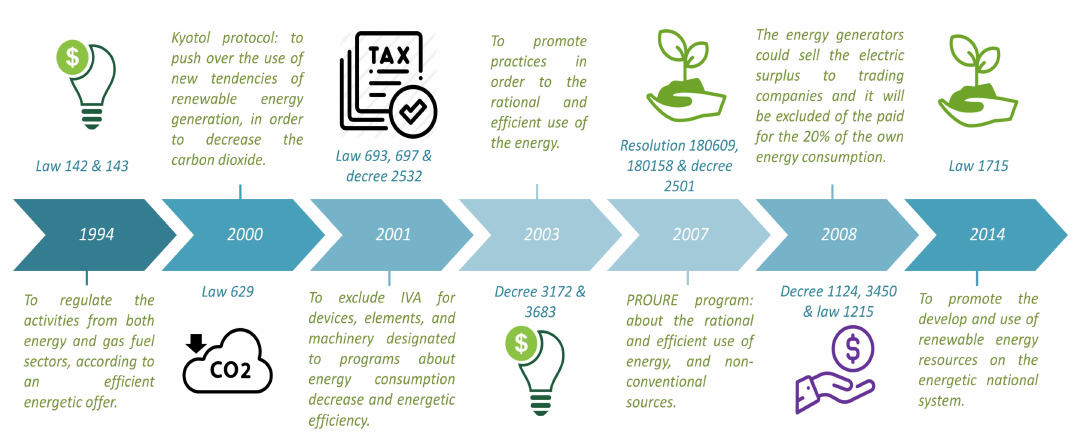
Figure 1. Timeline of the legal and regulatory framework for energy management in Colombia